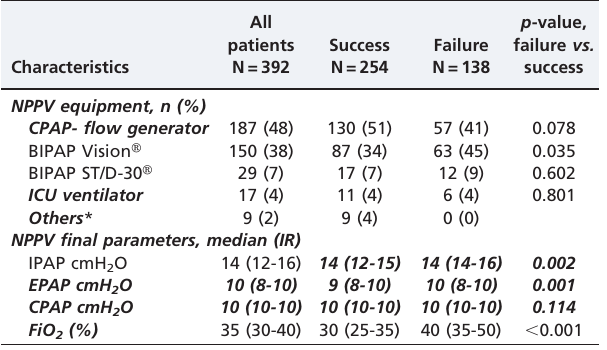
Table 3 - Technical characteristics of noninvasive ventilation: final equipment and parameters applied, according to the noninvasive ventilation